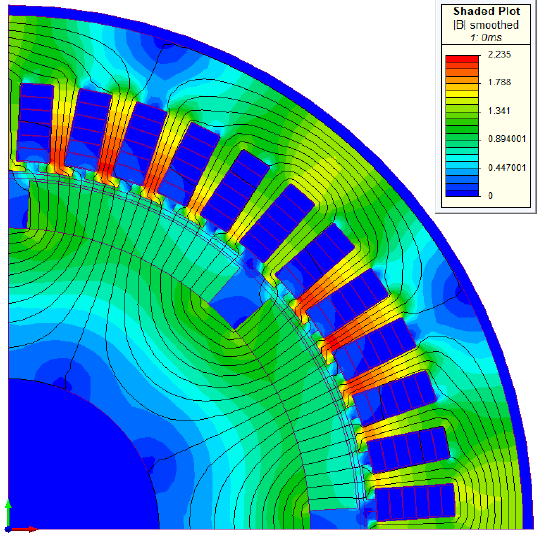
Figure 3. FE one pole pair model of the motor with the hairpin winding, highlighting flux density map (T) and field lines distribution at full-load operation.